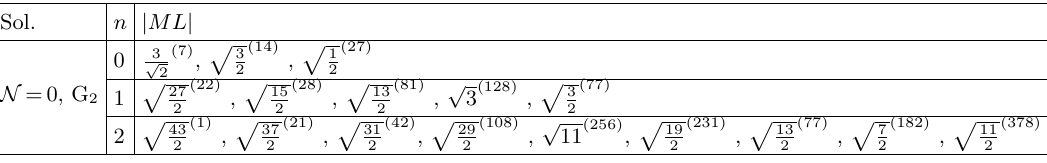
Table 23 . The KK spin- 1 / 2 spectra up to KK level n = 2 about the massive type IIA AdS 4 solution that uplifts on S 6 from the N = 0 G 2 -invariant vacuum of D = 4 N = 8 ISO(7) dyonically-gauged